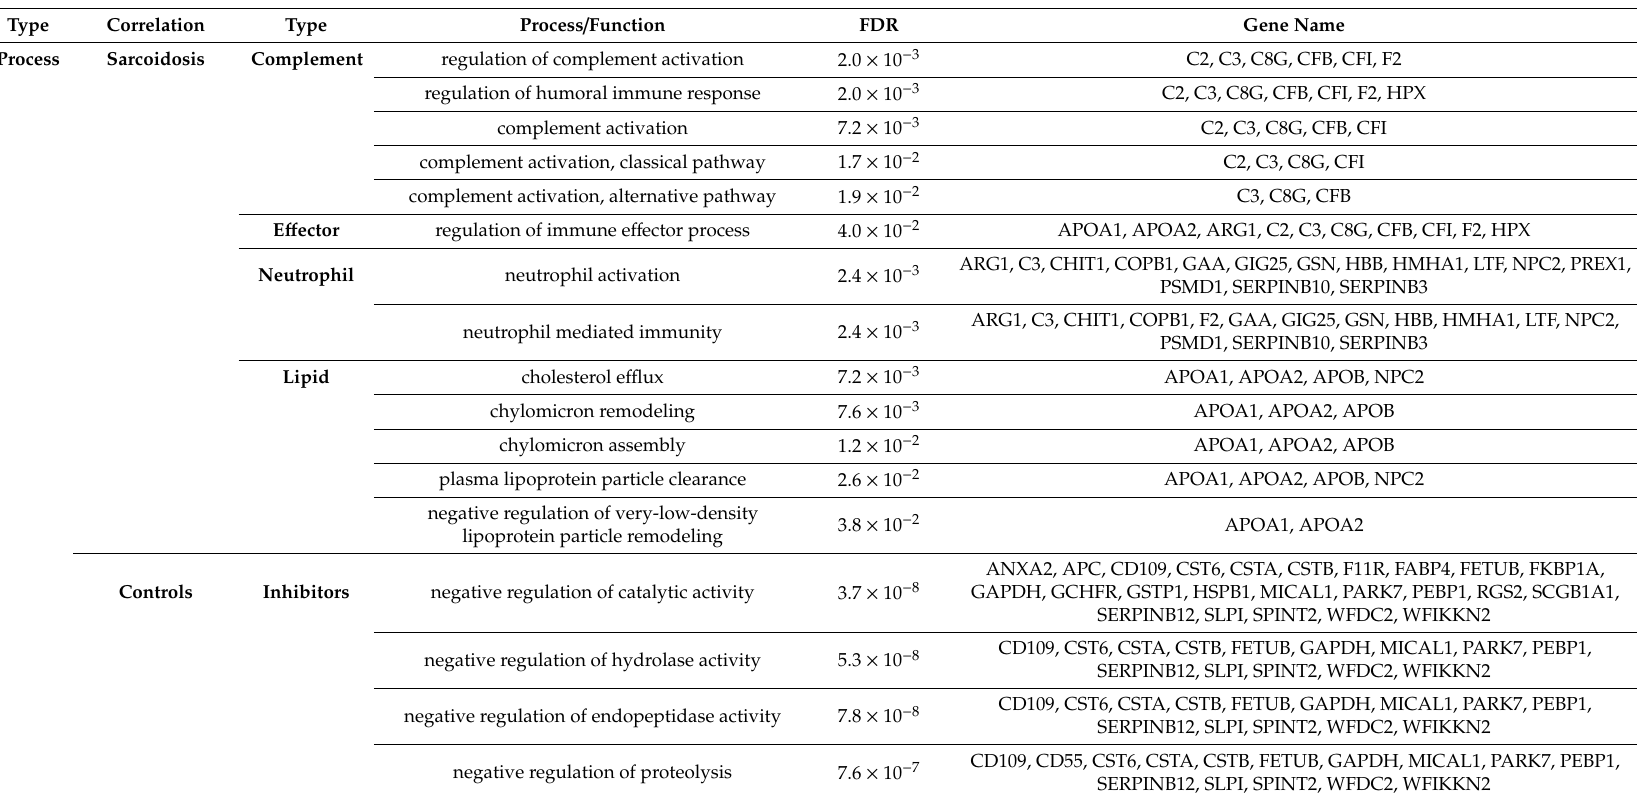
Table 1. STRING analysis of proteins / peptides that were significantly different in BALF between controls and sarcoidosis patients following FDR-correction. Note that many of the proteins are intertwined and found under several processes, functions, and types. Also, note that the peptidase activities in the control and sarcoidosis groups are different. The gene name abbreviations are given in the